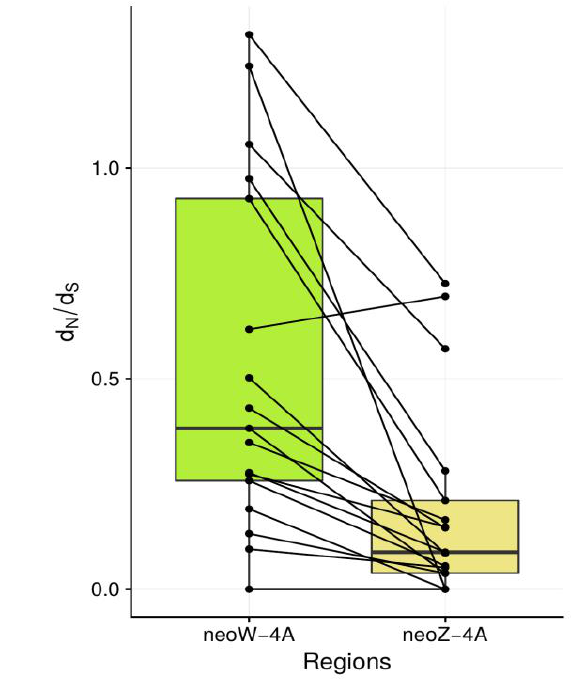
Figure 7. The d N /d S ratios of the neoW-4A and neoZ-4A copies (gametologs) of the Zosterops borbonicus genomes. For each gene, horizontal lines linked values of the two gametologs.